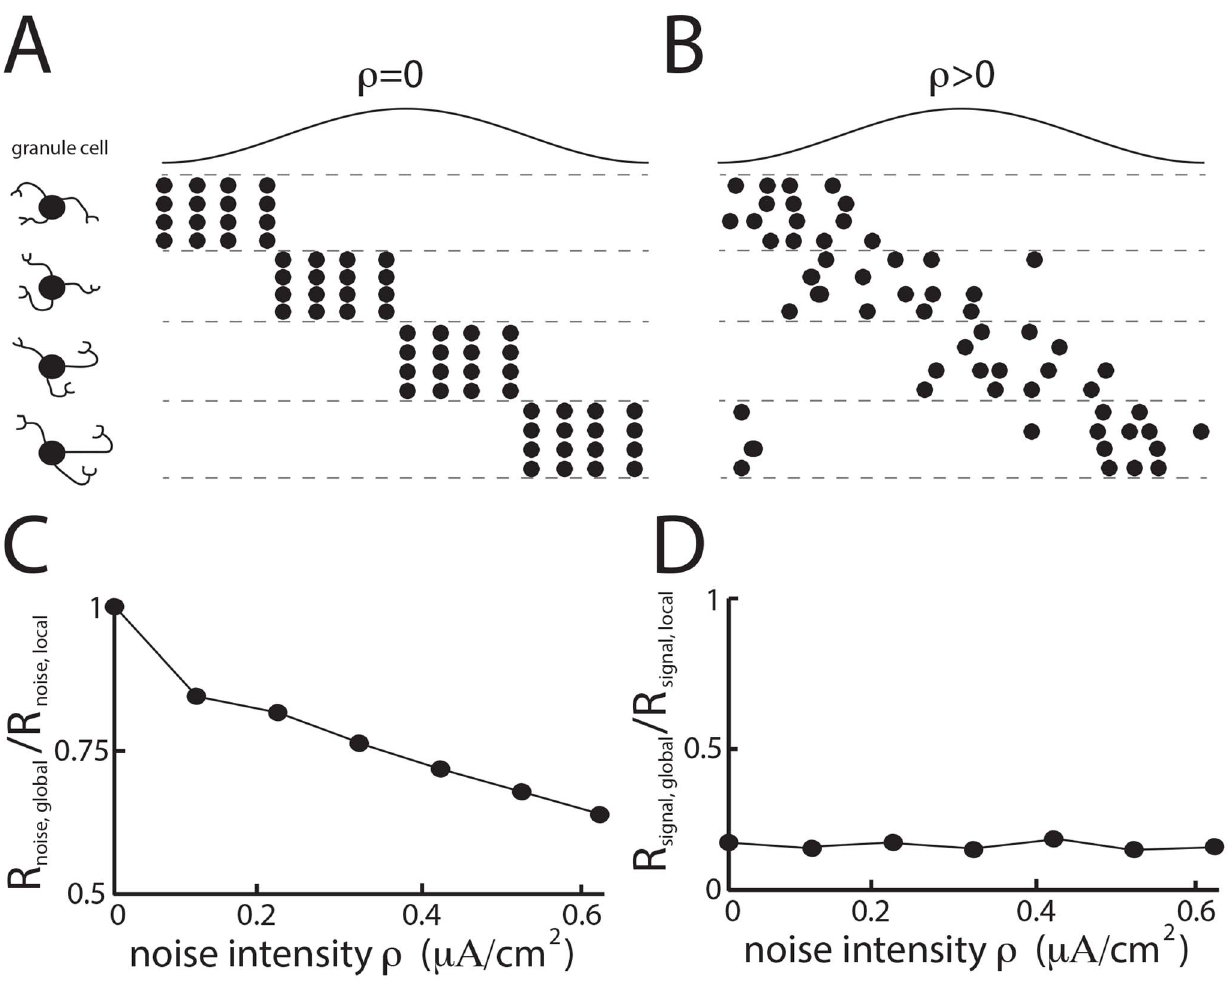
Fig. 4. Trial-to-trial variability of granule cell firing reduces noise correlations under global stimulation. A ) Raster plots showing responses of four different granule cells to repeated cycles of the sinusoidal stimulus in the deterministic regime for the granule cells (i.e. r =0). B ) Raster plots showing trial-to-trial variability in the responses of four different granule cells to repeated cycles of the sinusoidal stimulus in the stochastic regime for the granule cells (i.e. r . 0). C ) Ratio of the noise correlation coefficients obtained under simulated local and global stimulation as a function of the noise intensity r . Note that the ratio decreases from 1 as r is increased from 0. D ) Ratio of the signal correlation coefficients obtained under simulated local and global stimulation as a function of the noise intensity r